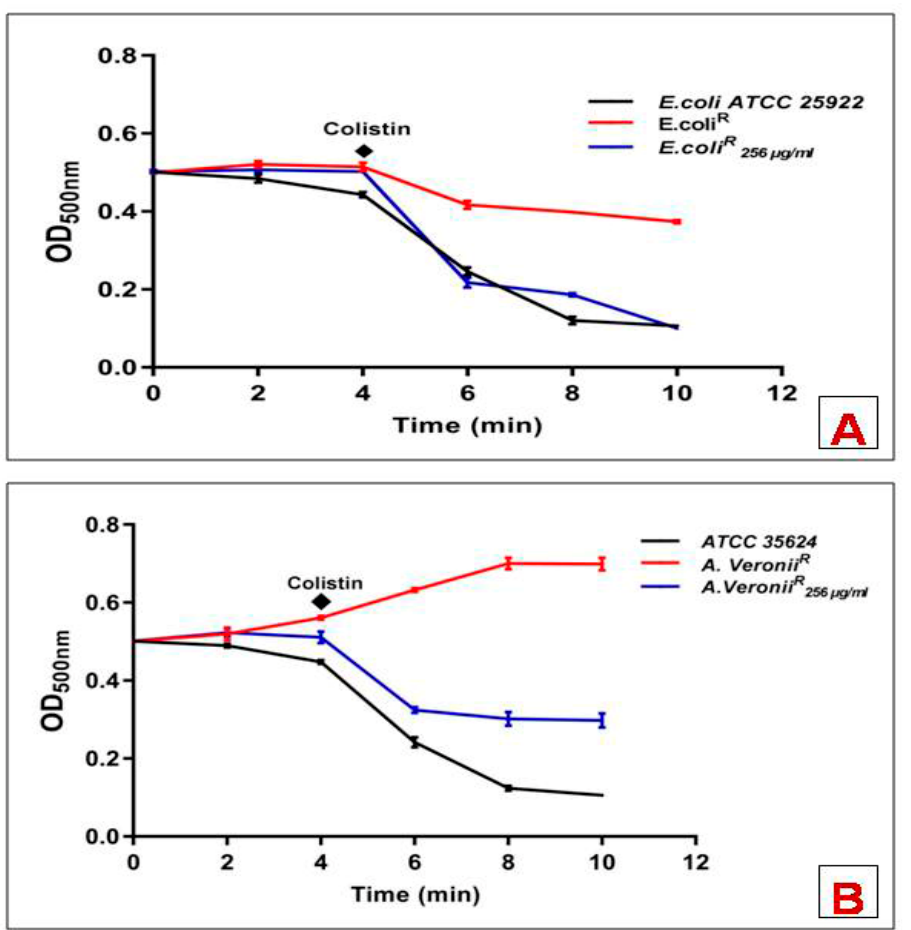
Figure 2. Lysozyme induced changes in OD 500 of mid-logarithmic phase cell suspensions of bacterial strains exposed to colistin ( A ) E. Coli ; ( B ) A. veronii. Data points are the mean ± SD of three independent measurements.